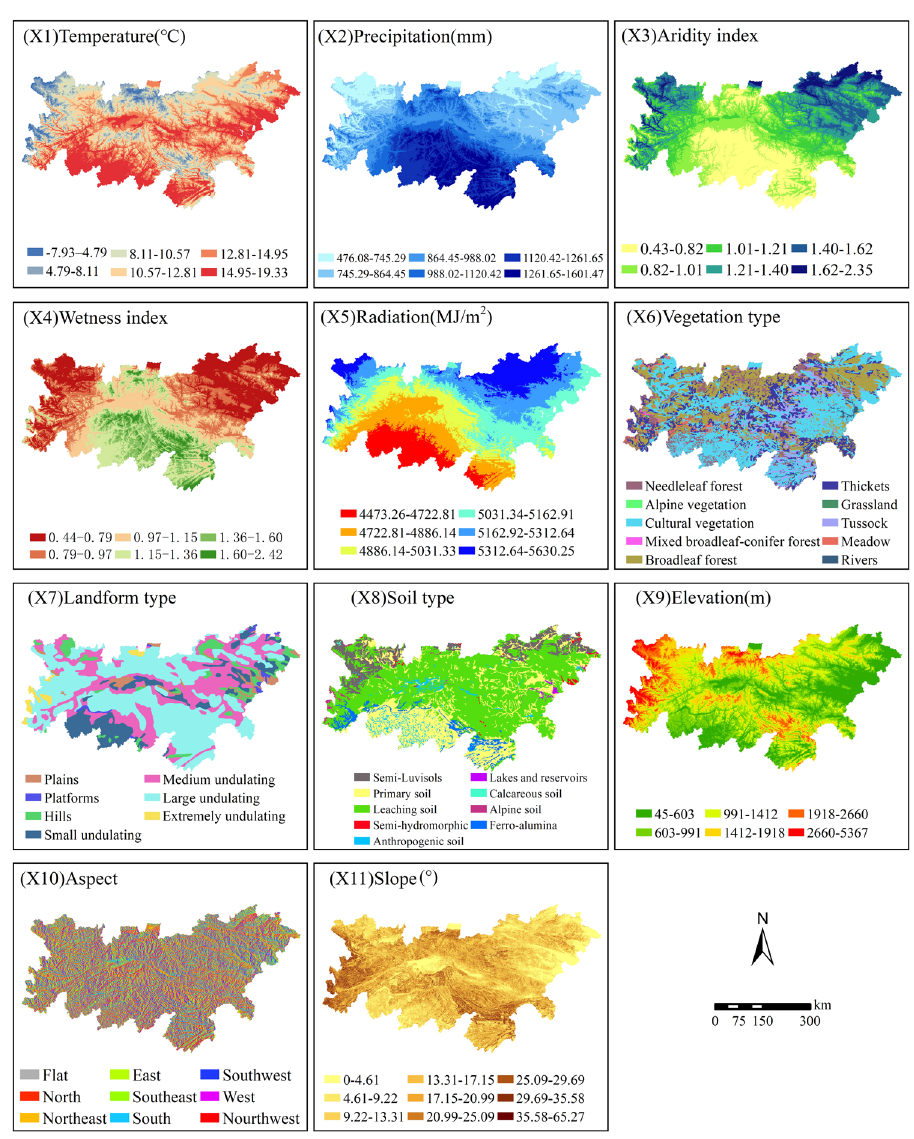
Figure 2. Spatial distribution of factors influencing the NDVI in the QBM. Note: temperature, precipitation, aridity index, wetness index and total radiation are the multi-year averaged variables.